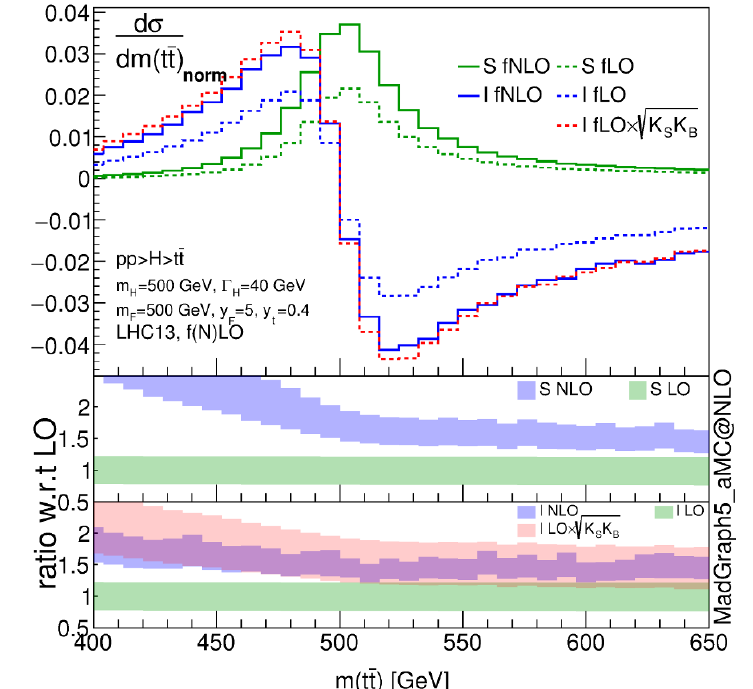
Figure 11 . Signal and interference lineshapes at (cid:12)xed order (N)LO for LHC 13 TeV. Results are normalised to the SM (cid:12)xed order at NLO (fNLO) lineshape. Lower panels show the K-factors and the scale uncertainties of signal and interference